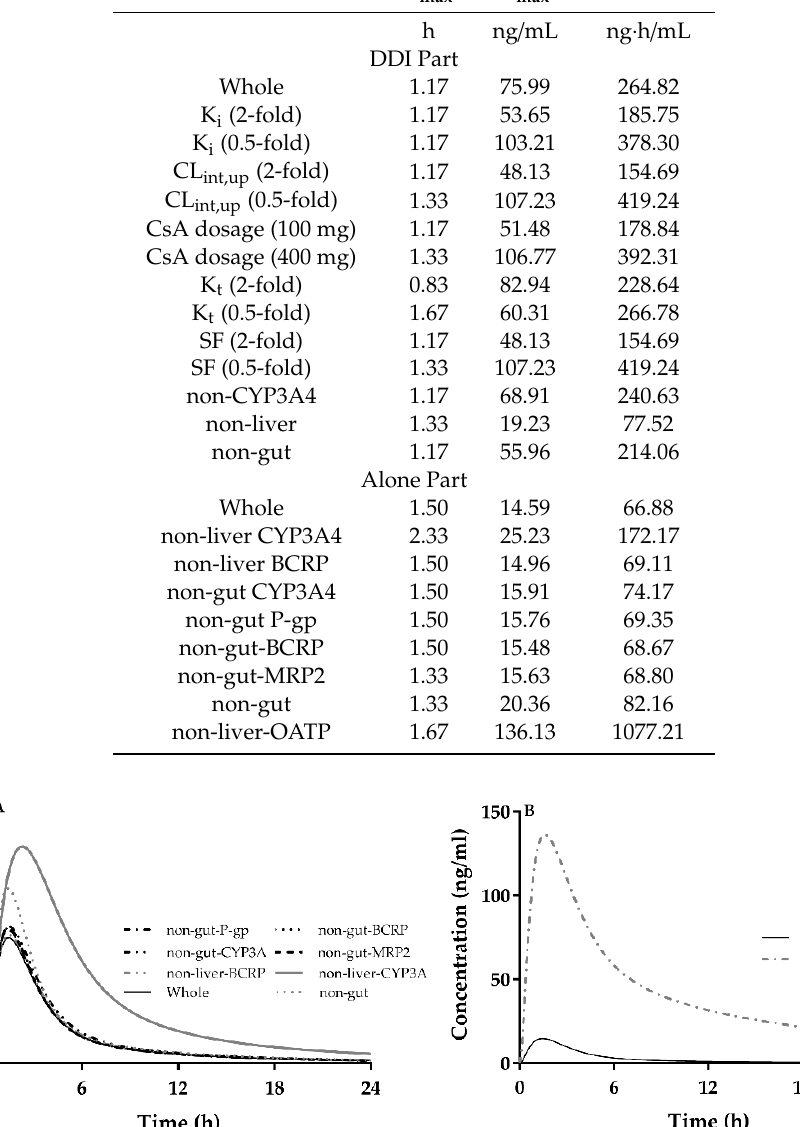
Table 7. Pharmacokinetics parameters of di ff erent factors on plasma concentrations of atorvastatin following 40 mg orally.